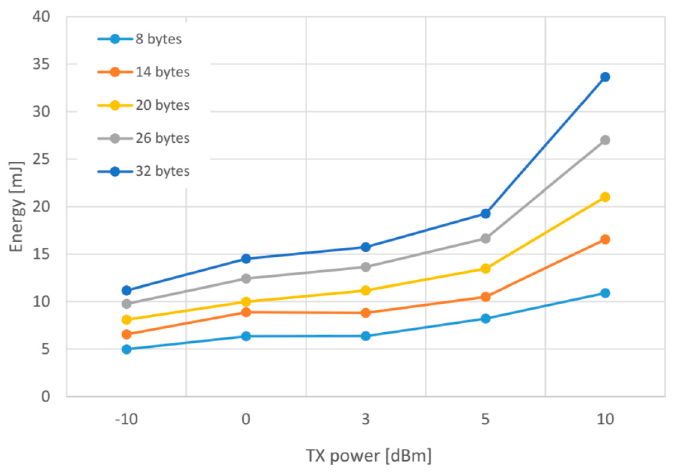
Figure 3. Measured energy consumption of CC1310 SoC as a function of the transmitted power and of the payload size.